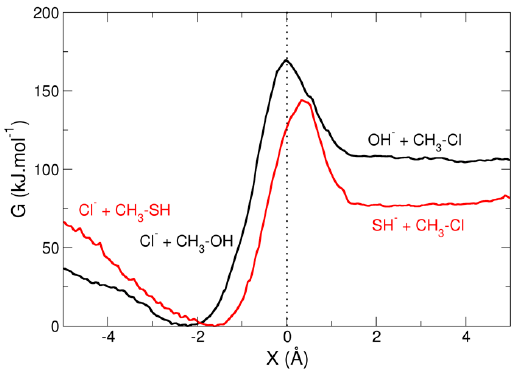
− (in black) or SH − (in